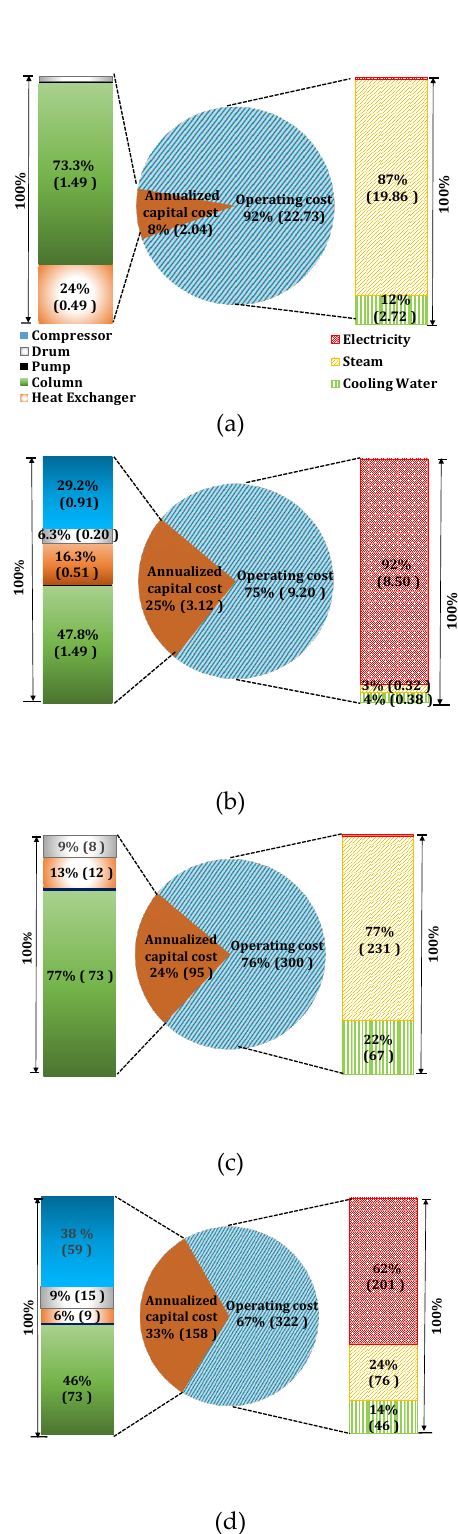
Figure 3. Cost contributions. The numbers in parentheses denote the costs (10 6 $/yr and 10 3 $/yr for the C4 splitter and de-propanizer, respectively): ( a ) Conventional C4 splitter, ( b ) heat pump-assisted C4 splitter, ( c ) conventional de-propanizer, and ( d ) heat pump-assisted de-propanizer.